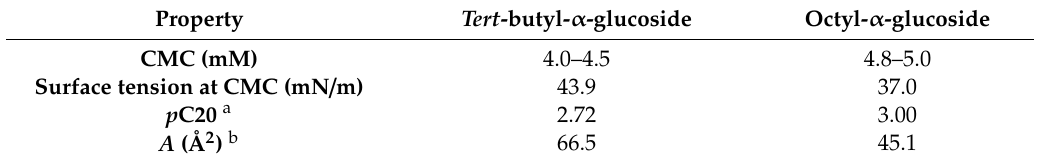
Table 2. Surfactant properties of tert -butyl-O- α - d -glucoside and octyl-O- α - d -glucoside.